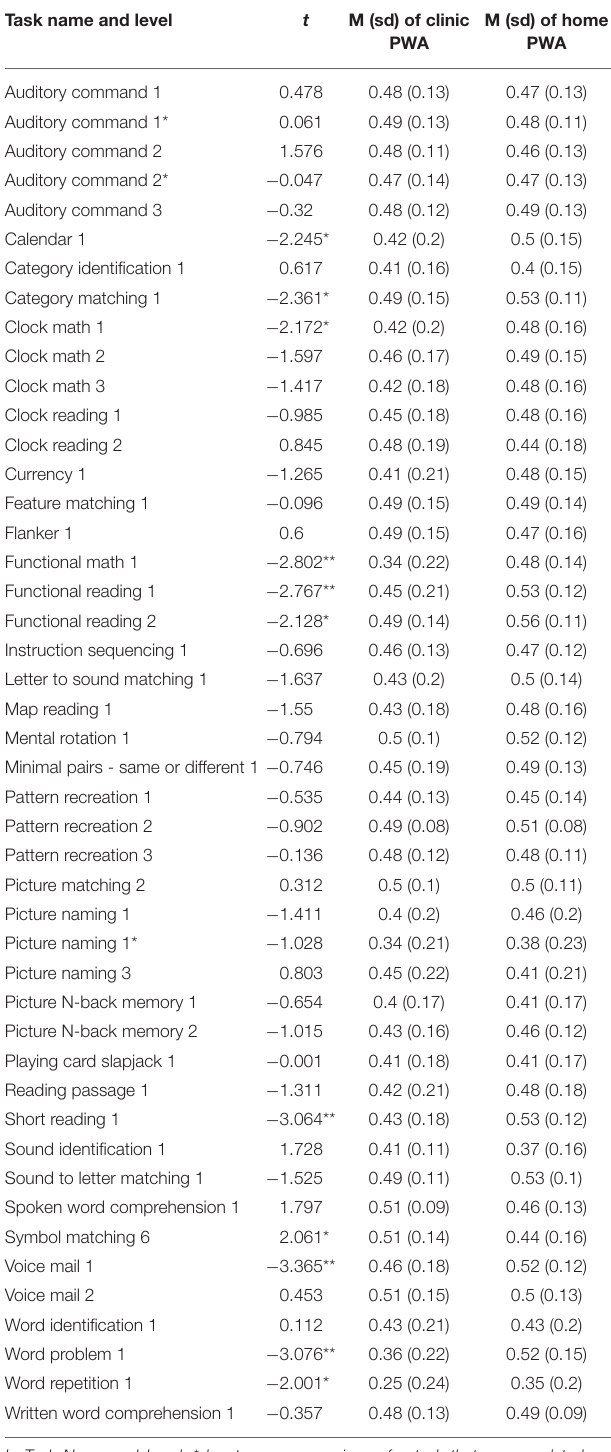
TABLE 4 | Group comparisons of starting accuracy for each